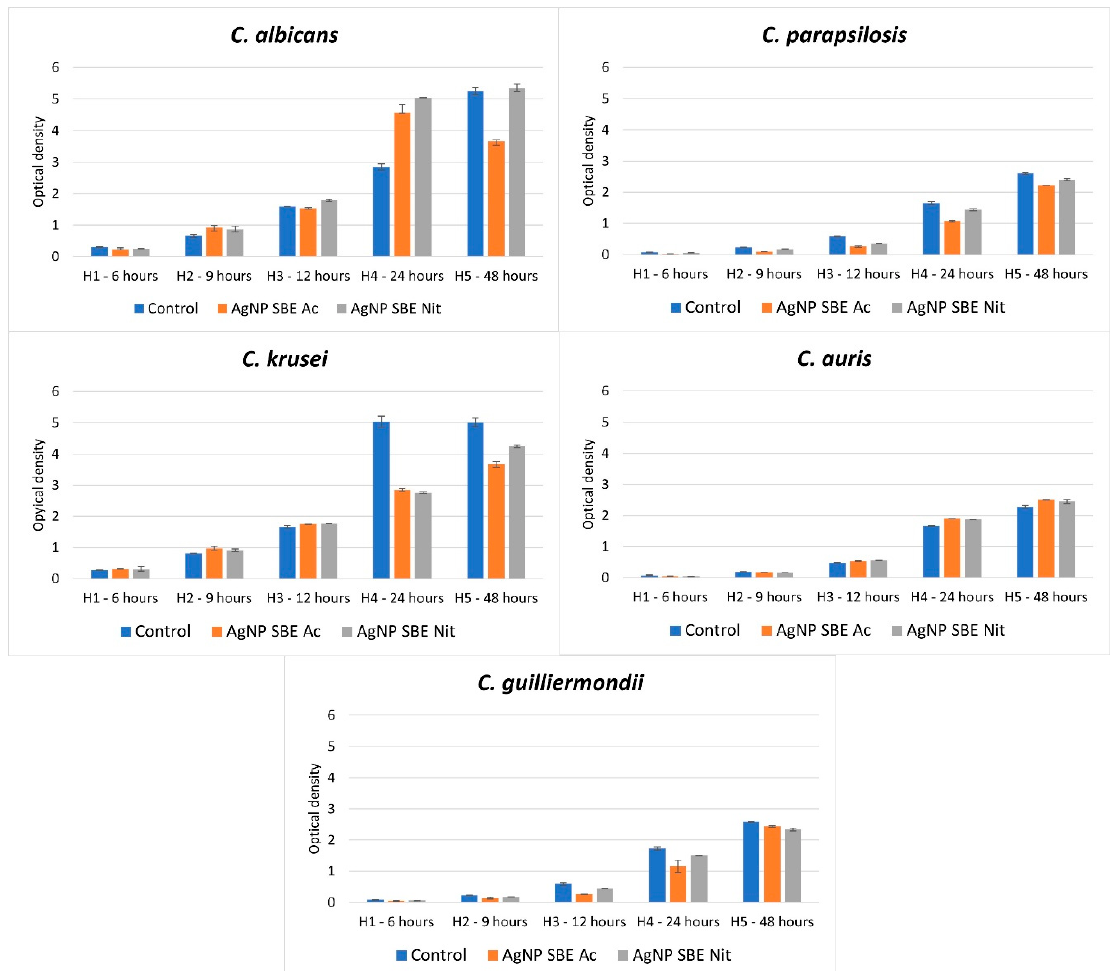
Figure 1. The influence of MICs of AgNP SBEs on the growth rate of Candida spp.